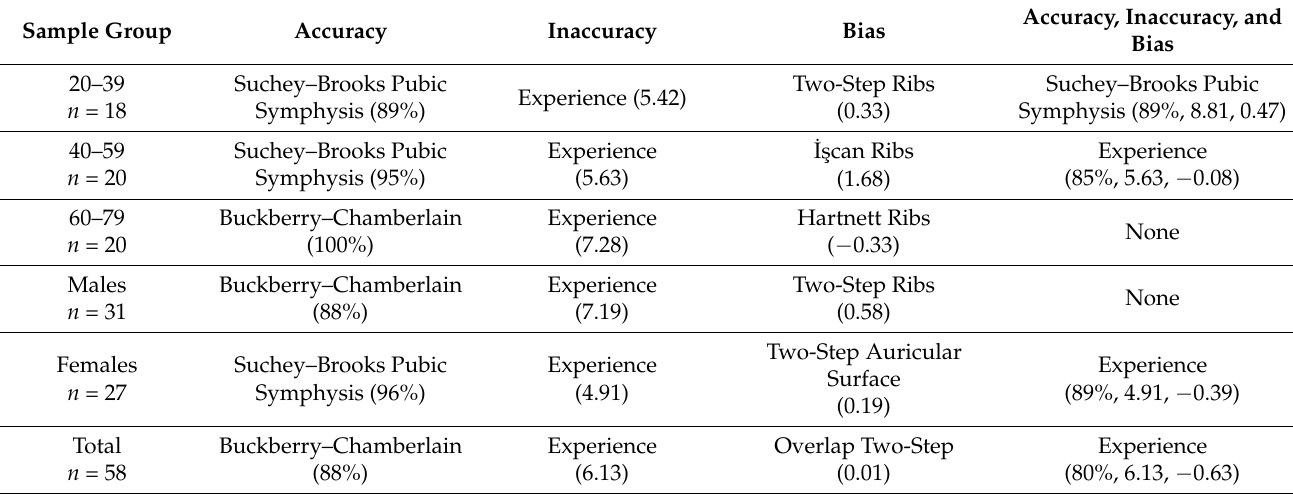
Table 7. Most accurate and reliable strategies by sample